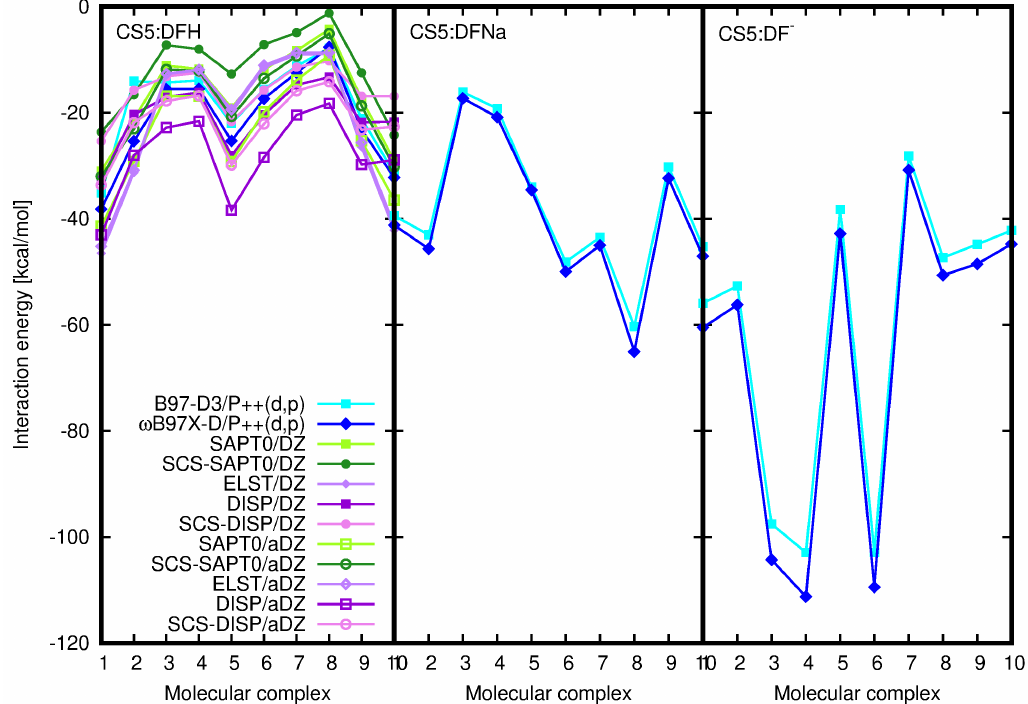
Figure 13. Counterpoise-corrected supermolecular B97-D3/6-311++G(d,p) and ω B97X-D/6-311++G(d,p) supermolecular interaction energy (blue lines) compared with SAPT0 results (green lines) and interaction energy components (violet lines) for CS5:DFH system and supermolecular data for CS5:DFNa and CS5:DF −